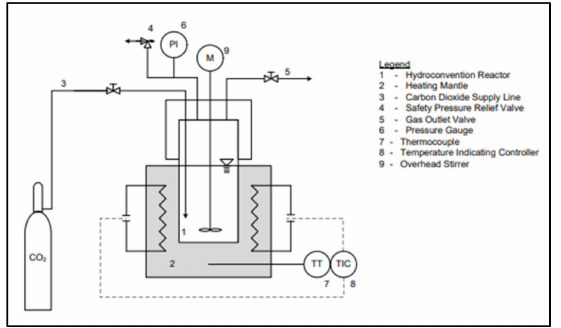
Figure 1. Schematic diagram of the reactor